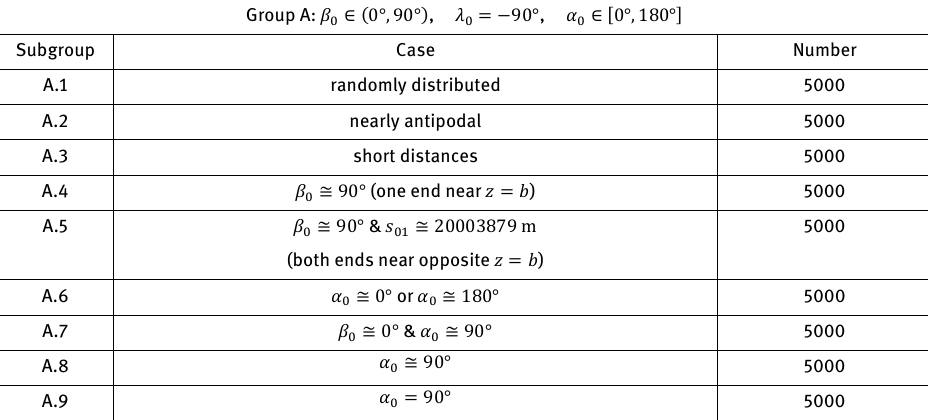
Table 5: Description of the geodesics in the Group A